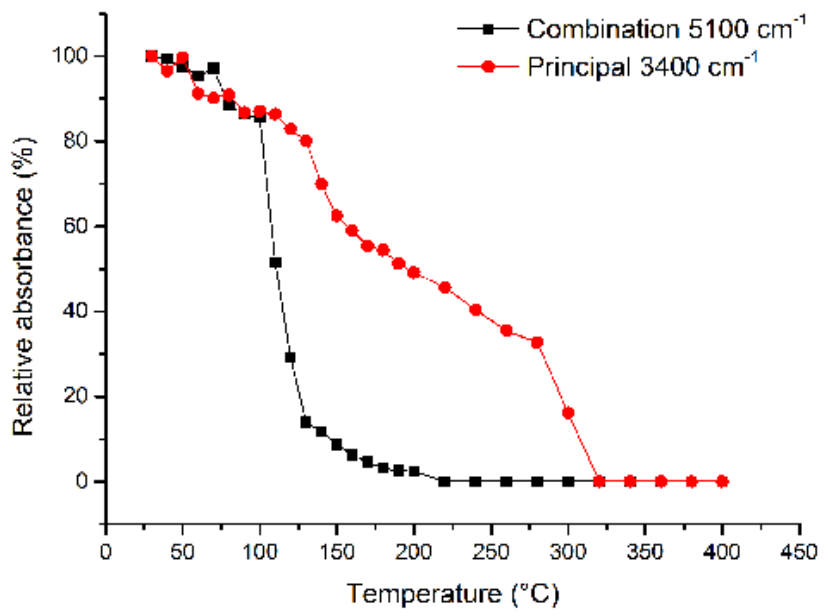
Figure 6. Evolution of relative absorbance (%) as a function of T of the principal H 2 O stretching peak (in red) and the H 2 O ( ν 3 + ν 1) combination mode in the HT-FTIR spectra (in black).